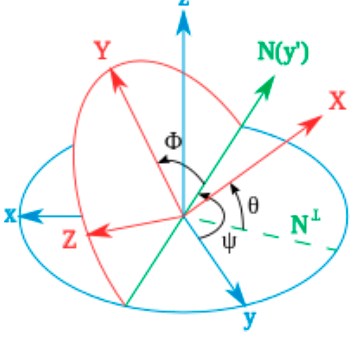
Figure 15. The fixed magnetometer and the acceleration axes.